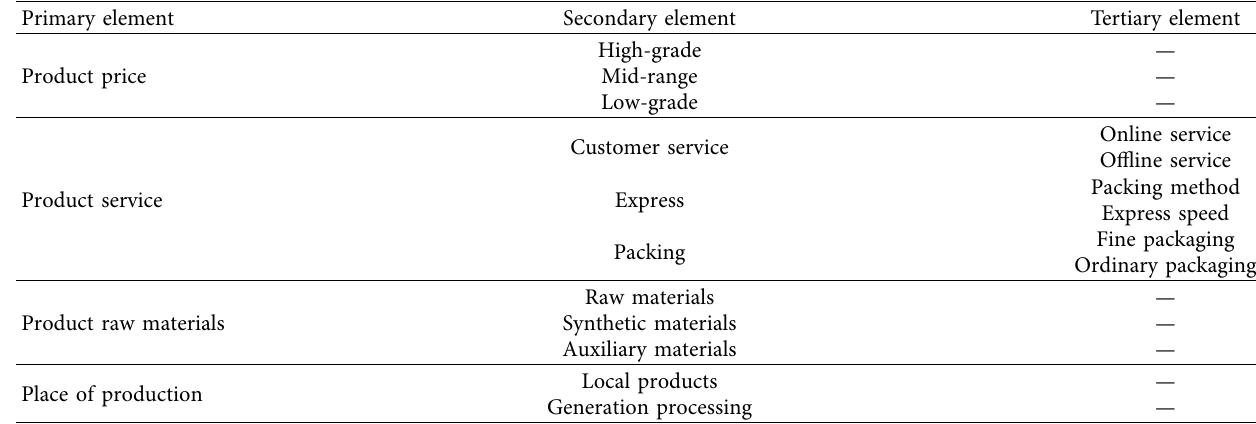
Figure 5: Mapping relationship between agricultural products and consumer demand. Table 1: Elements of consumer demand for agricultural